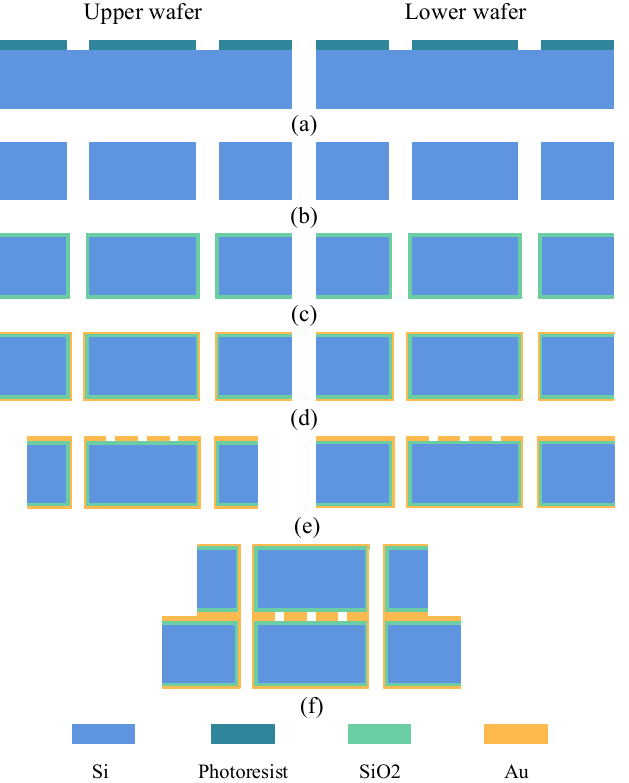
Figure 7. The fabrication processes of the interdigital filter. ( a ) Pattern the hole photoresist. ( b ) Etching via-hole. ( c ) Preparation of isolation layer. ( d ) Sputter the seed layer. ( e ) Electroplating surface structure. ( f ) Au–Au bonding.